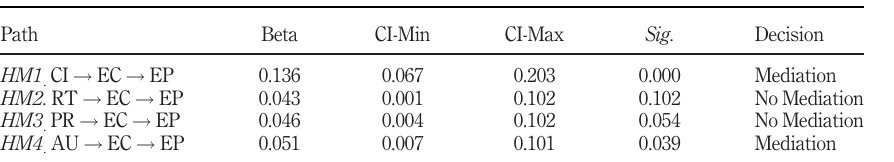
Table V. Mediating effects